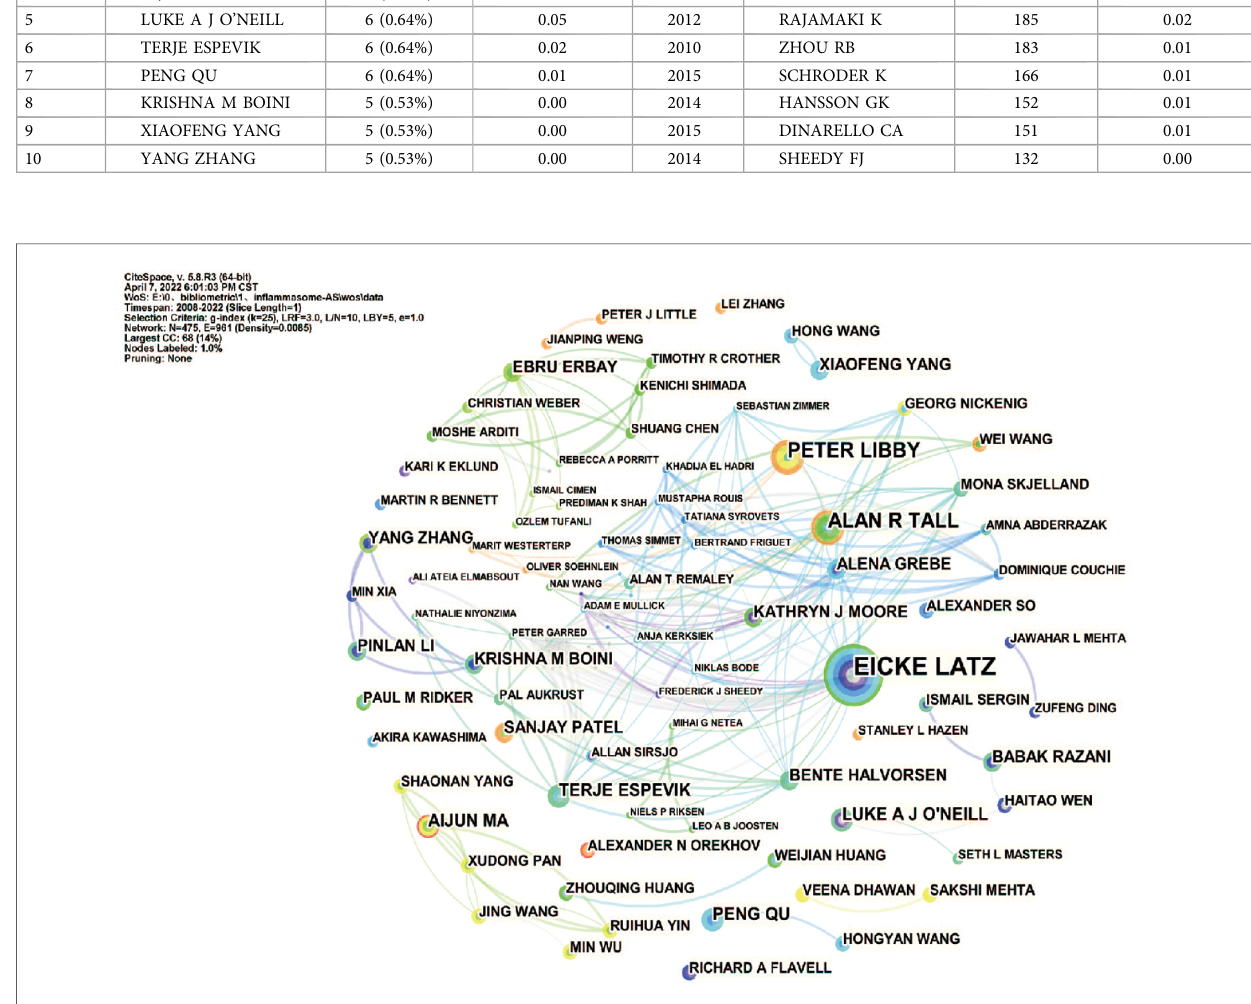
FIGURE 4 Citespace visualization map of authors involved in “ in fl ammasome AND atherosclerosis ”